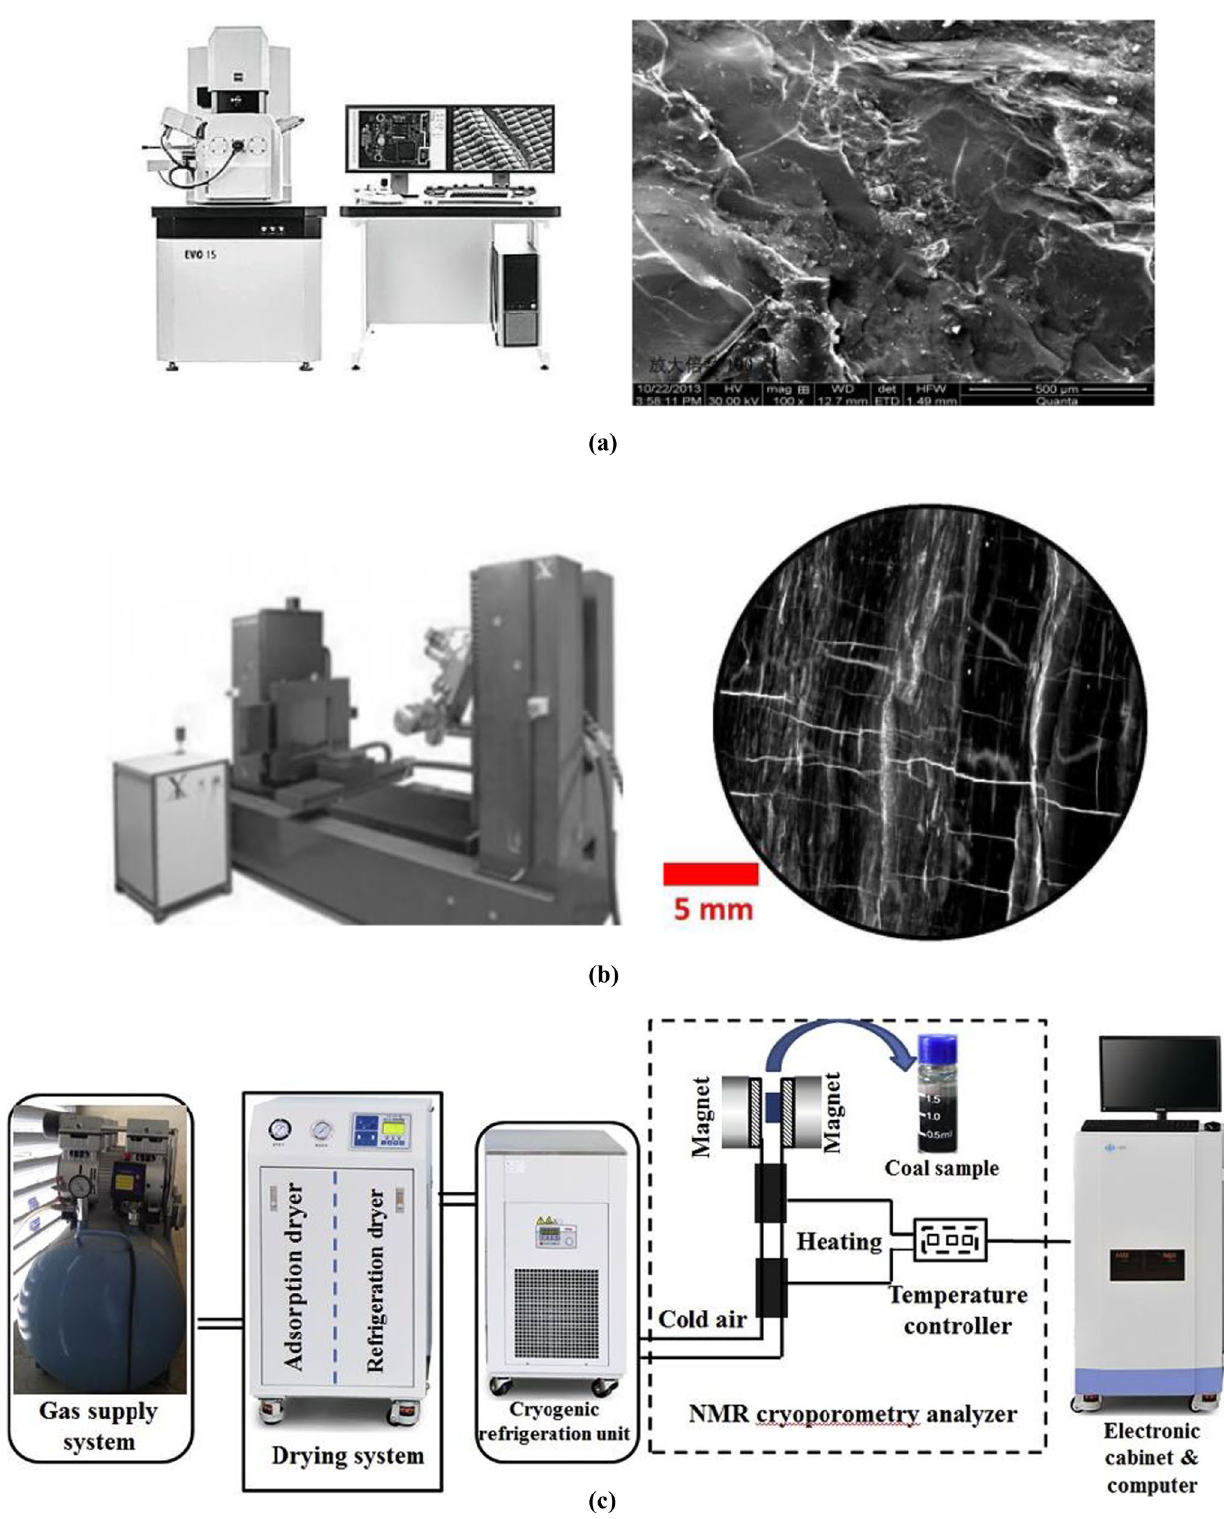
Fig. 3 SEM/CT/NMR microsystem. a SEM (Zou et al. 2016), b CT (Jing et al. 2017; Wang et al. 2019a, b, c, d), c NMR (Zhao et al.